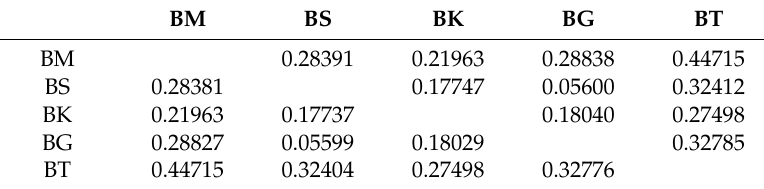
Table 4. The pairwise Fst values of di ff erent populations in D. maculates .